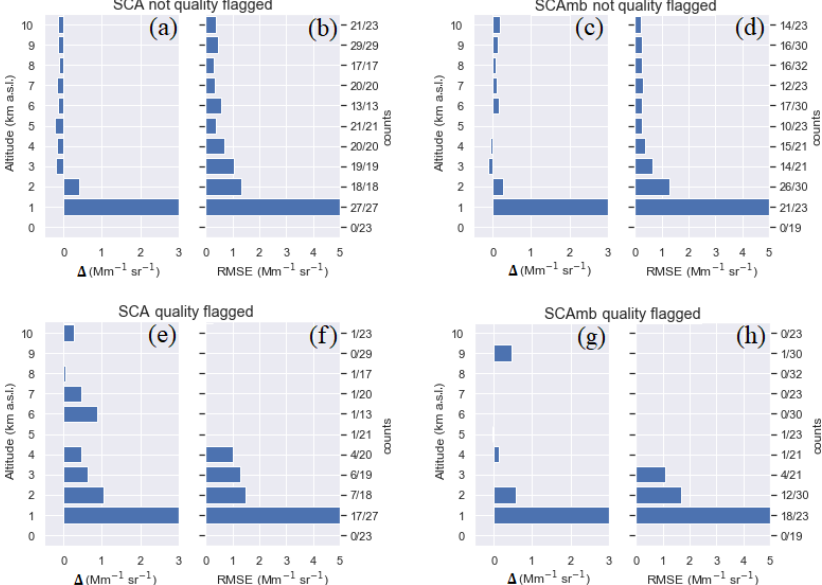
Figure 15. Statistical results for the intercomparison of Aeolus SCA and SCAmb products with Granada ground-based measurements, with and without quality flags. The right-hand axis indicates the number of available data points included in each vertical range out of the total number of measurements within that vertical range. The (a) difference ( (cid:49) ) and (b) RMSE of the intercomparison of the SCA products without quality flags applied. The (c) (cid:49) and (d) RMSE of the intercomparison of the SCAmb products without quality flags applied. Panels (e) and (f) are the same as panels (a) and (b) , respectively, but considering quality flags. Panels (g) and (h) are the same as panels (c) and (d) , respectively, but considering quality flags.